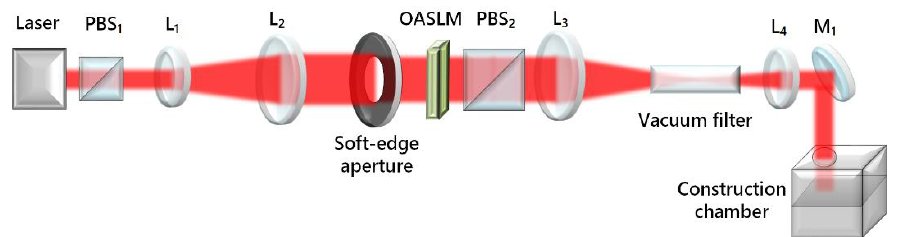
Figure 1. Layout of the optical system of the additive manufacturing scheme of the surface exposure (SE) technology. PBS 1 , and PBS 2 : Polarizing beam splitter; L 1 : concave lens; L 2 , L 3 , and L 4 : convex lenses; OASLM: optically addressed spatial light modulator; M 1 : mirror.